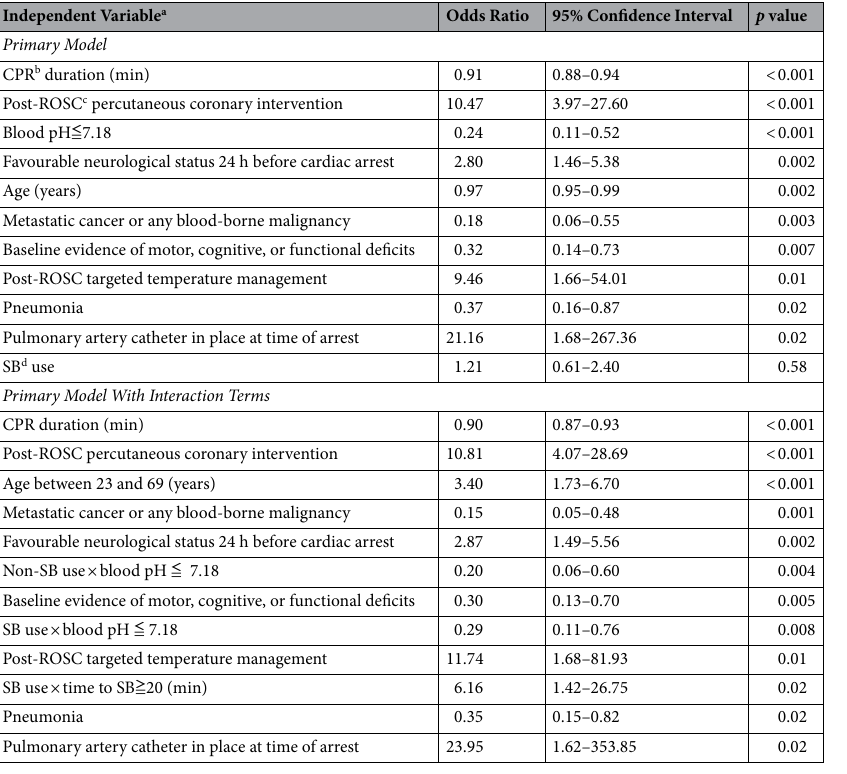
Table 3. Multiple Logistic Regression Model With Favourable Neurological Outcome at Hospital Discharge as the Dependent Variable. Primary model: goodness-of-fit assessment: n = 1060, adjusted generalised R 2 = 0.40,estimated area under the receiver operating characteristic curve = 0.91, and Hosmer and Lemeshow goodness-of-fit Chi-Squared test p < 0.001; Primary model with interaction terms: goodness-of-fit assessment: n = 1060, adjusted generalised R 2 = 0.43, estimated area under the receiver operating characteristic curve = 0.92, and Hosmer and Lemeshow goodness-of-fit Chi-Squared test p < 0.001. a The display of independent variables is arranged in order of p value. b CPR, cardiopulmonary resuscitation. c ROSC, return of